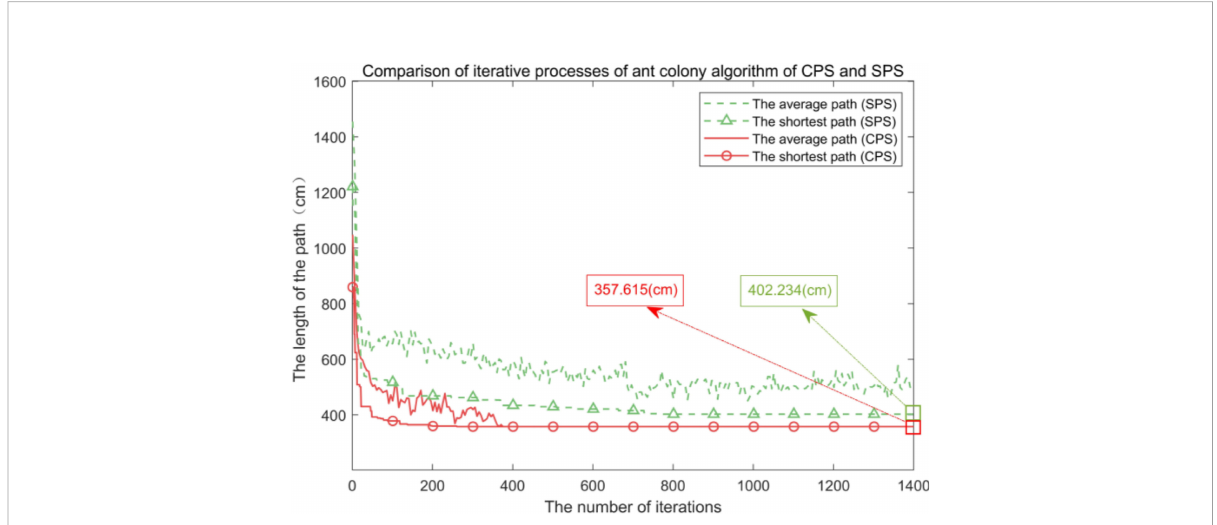
FIGURE 13 Comparison of the average shortest picking path and the shortest picking path of the two picking schemes.